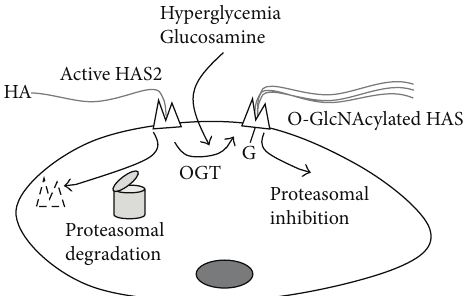
Figure 3: Schematic representation of the regulation of HA syn- thesis by OGT in SMCs. In normal conditions HAS2 in plasma membrane is active but can be rapidly degraded in a 26 S pro- teasome dependent manner. In hyperglycemic condition or after glucosamine treatments, OGT catalyzes the O-GlcNAcylation of HAS2 serine 221 residue, which greatly stabilizes HAS2 favoring HA production.